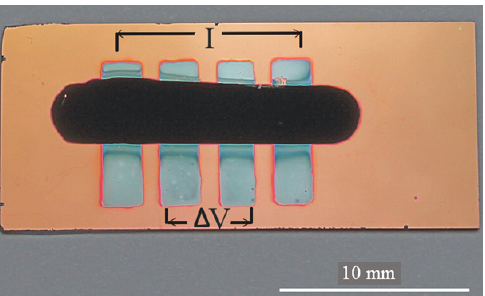
Figure 1. CNWs deposited onto electrode configurations for MR measurements.